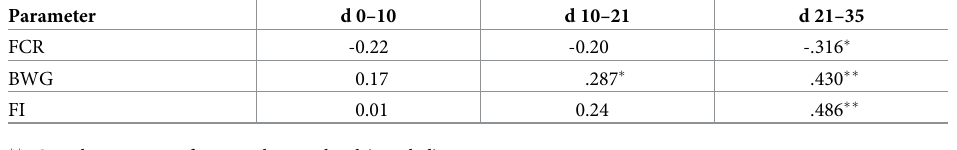
Table 7. Correlations between the independent variables and the covariate male % for each phase for Experiment 3. Parameter